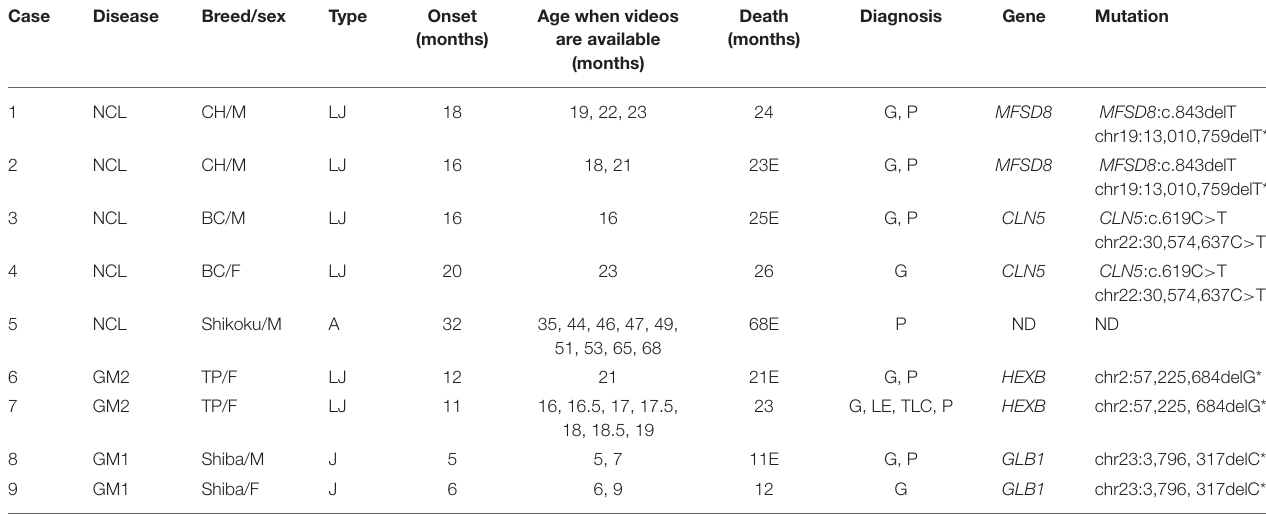
TABLE 1 | Summary of the cases studied. Case Disease Breed/sex Type